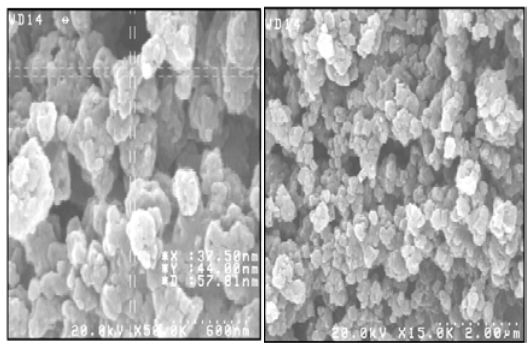
Fig.3. SEM photographs of compound 1 nanoparticles produced by sonochemical method by 0.01:0.01 M concentration of initial reagents in two scale.